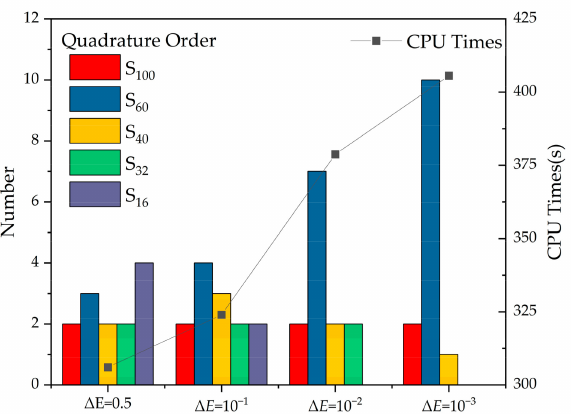
Figure 6. Effect of the tolerance criterion ( ∆ E ) on the number of times the quadrature is used and the efficiency.